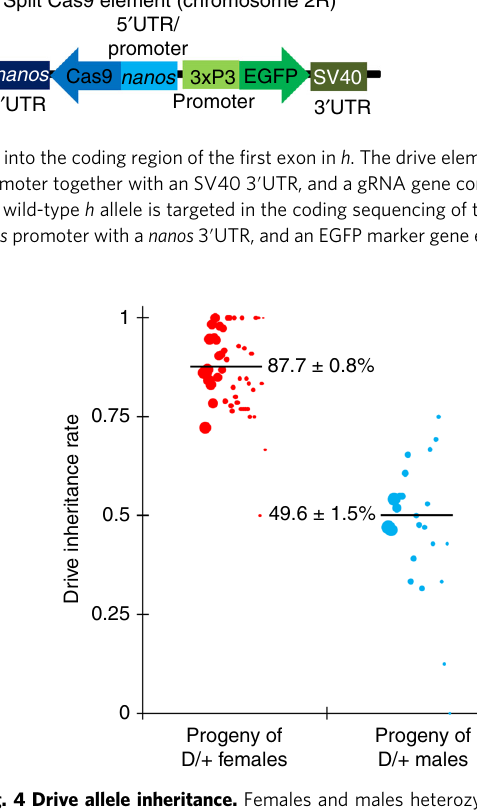
Fig. 4 Drive allele inheritance. Females and males heterozygous for the drive allele and the Cas9 allele were crossed with w 1118 individuals, and their progeny were phenotyped for dsRed, which indicates the presence of the drive. Females showed biased inheritance of the drive, since many individuals without the drive had two disrupted copies of h and thus were nonviable. Half of the progeny of male drive heterozygotes received the drive, since individuals that received a disrupted copy of h still received a functional wild-type copy from their mother that remained undisrupted in the absence of maternal Cas9 activity. The size of the dots represents the sample size of adult progeny from a single drive individual. The rate estimates and corresponding estimates of the standard error of the mean (SEM) are displayed, obtained from pooling offspring from all crosses of the same type together ( n = 1598 for the progeny of females and n = 706 for the progeny of males). An alternative statistical analysis that accounts for potential batch effects was also performed but yielded overall similar rates with only slightly increased error estimates (Supplementary Methods, Source Data: Data Sets 1 −